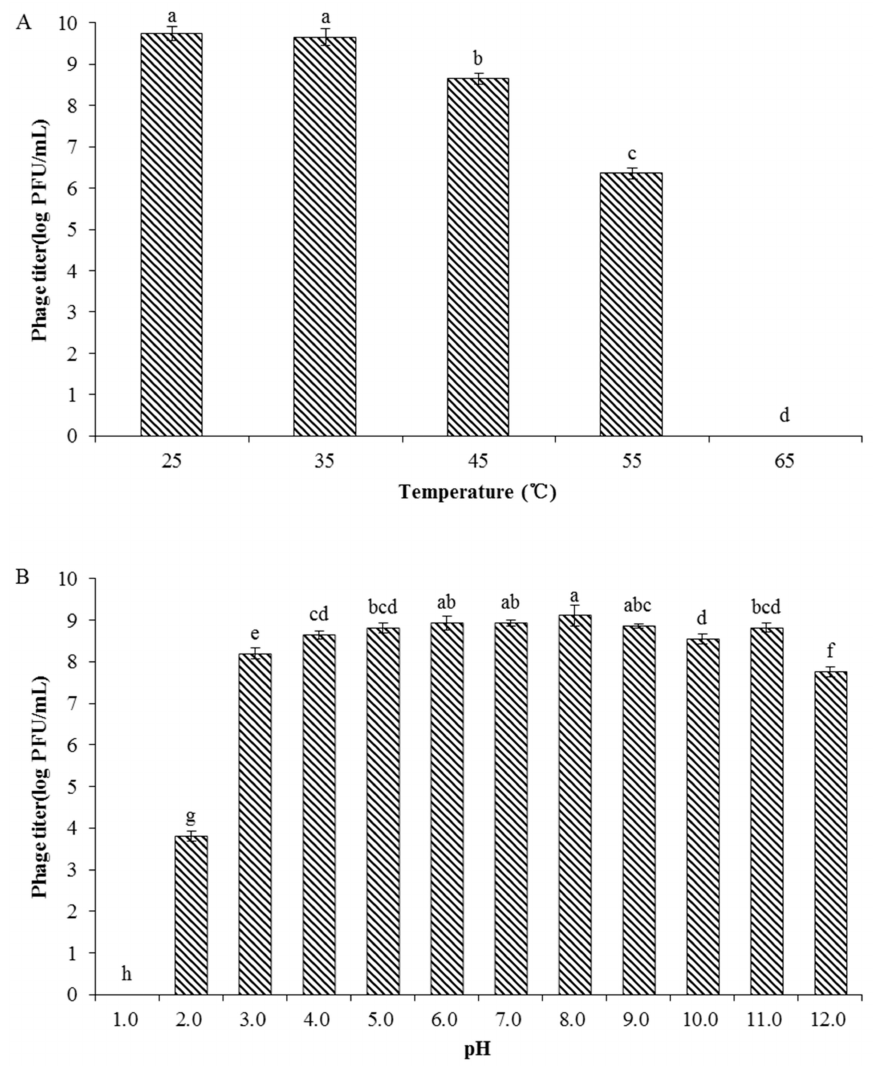
Figure 3. Stability of phage PN09. ( A ) Thermostability ( B ) pH stability. The means and standard deviations of three independent assays are shown. Shared letters above bars indicate no statistical difference among groups ( p > 0.05) and different letters above bars indicate a statistically significant difference ( p < 0.05). Phage PN09 showed a relatively high survival rate at pH